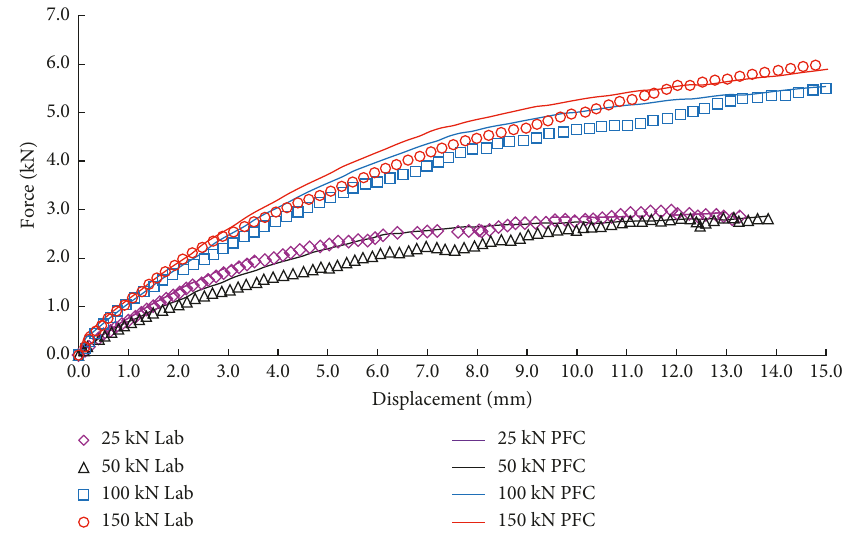
Figure 5: Force-displacement curves of Pull-out test under various vertical